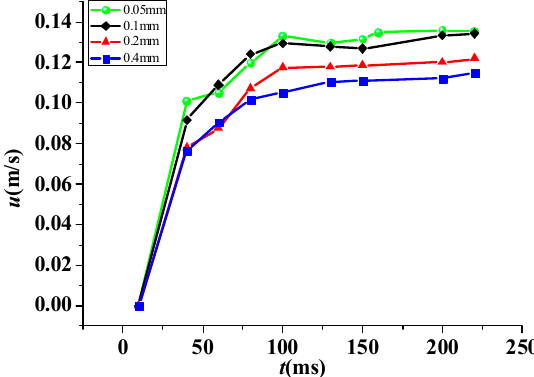
Figure 1. Study of grid independence on the simulated bubble.